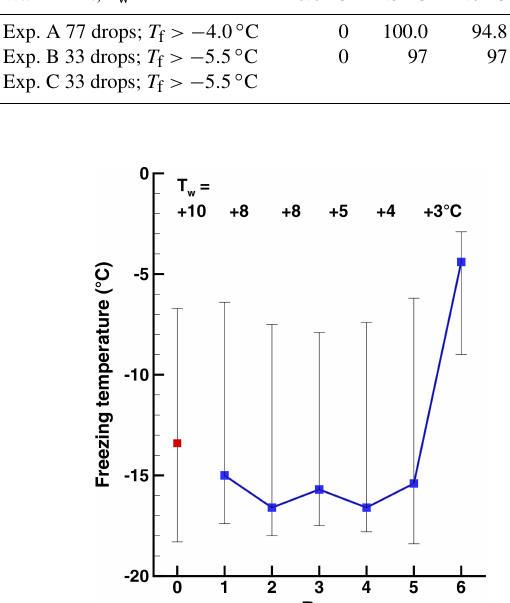
Figure 5. Freezing temperatures in a sequence of runs (Exp. C) with decreasing warm limit, T w . The 50% is indicated by the square symbols, and the vertical lines show the 10th- and 90th-percentile